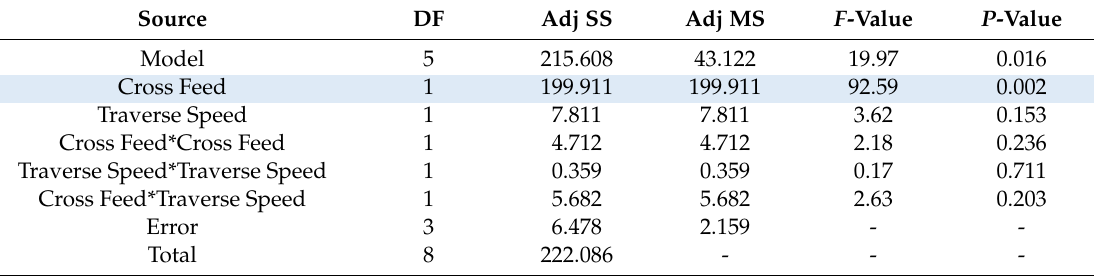
Table 6. ANOVA analysis of the surface quality obtained in laser texturing.